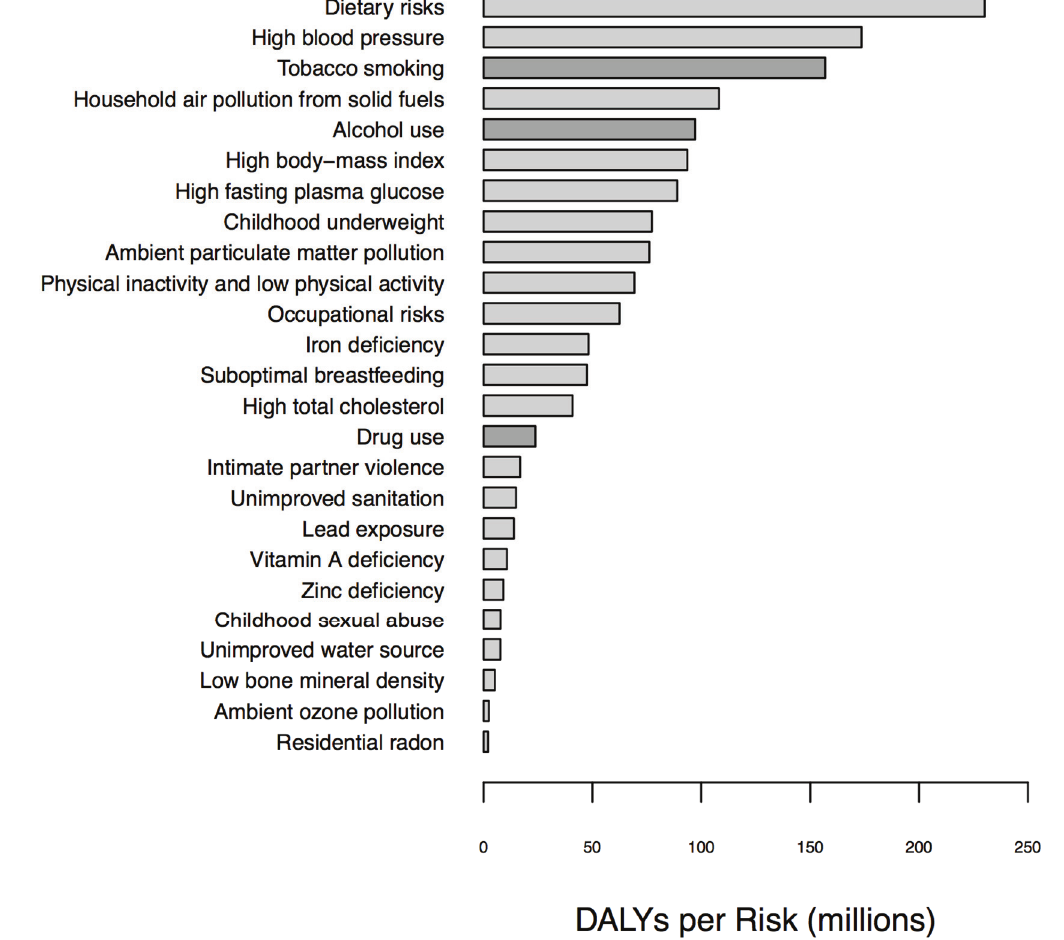
Figure 1. Global disability-adjusted life years (DALYs) annually by risk